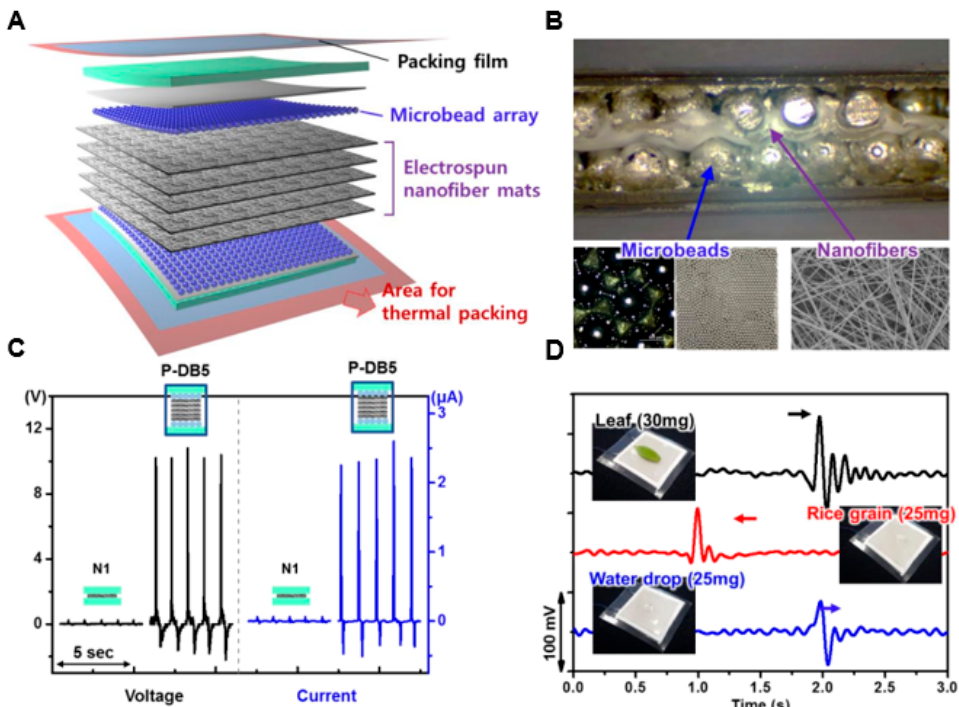
Figure 9. Structure and central performance characterization of multilayer electronic device. ( A ) Illustration of the overall components of the piezoelectric device with microscopic photographs of the microbead array. ( B ) Cross-sectional images of the vacuum-packed devices with P-DB5 and an SEM image of the electrospun nanofiber mat. ( C ) Relationship between the output performances of voltage and current varied by the applied pressure using the device with P-DB5. ( D ) Output signals of the drop test results using a small leaf, a grain of rice, and a water droplet. Reproduced from [227] with permission from the American Chemical Society; Copyright 2018.